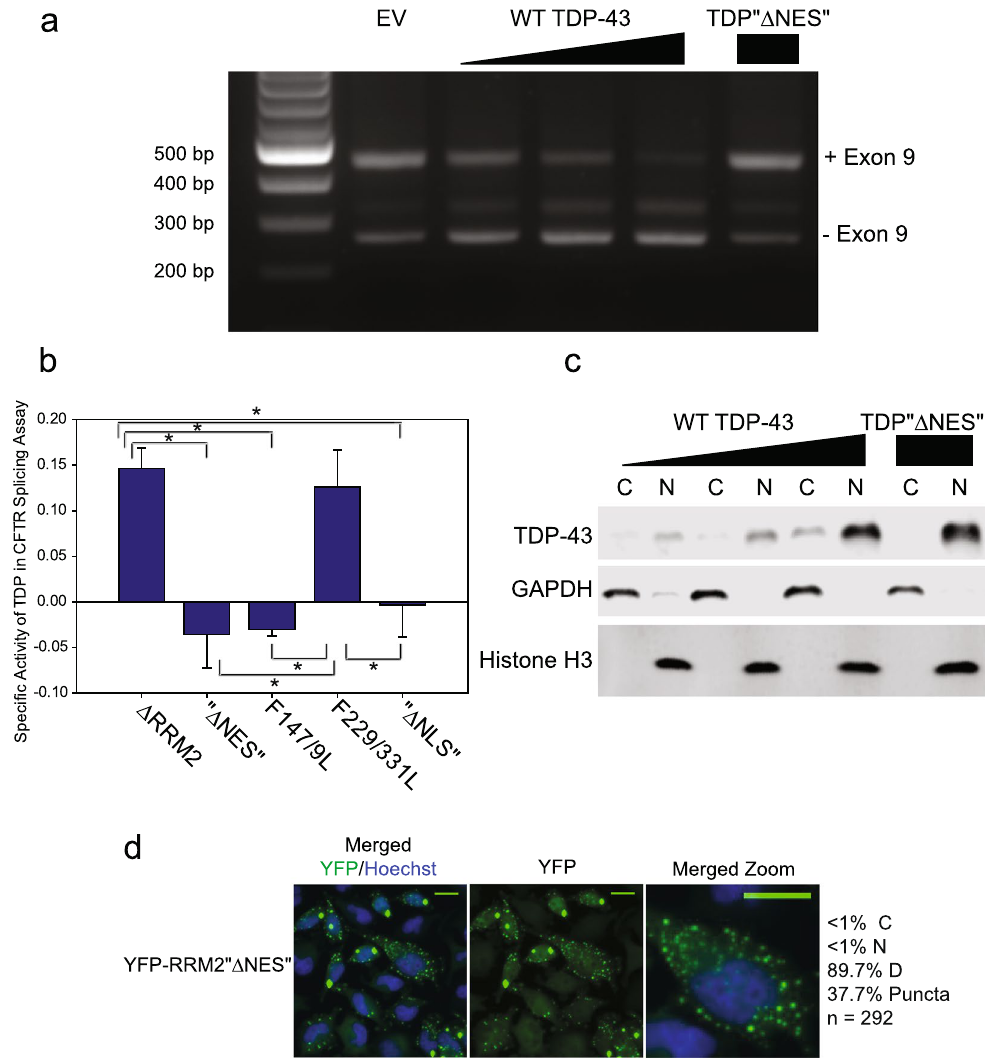
Figure 4. “ ∆ NES” Mutations profoundly disrupt TDP-43 function. ( a ) CFTR exon splicing Assay. HeLa were cells co-transfected with the CFTR minigene and either empty vector (EV) or TDP-43. cDNA was PCR amplified and run on an agarose gel. Image is representative of three independent experiments. Uncropped image shown in Supplementary Fig. 4a. ( b ) qPCR analysis of HeLa cells co-transfected with the CFTR minigene and TDP-43. The “ + 9” and “ − 9” isoforms were detected with sequence specific primers. The specific activity: (( + 9)/( − 9))/(TDP-43) was calculated for each TDP-43 variant and normalized to WT (set to 1). The mean and standard deviation from three independent experiments are plotted (WT not shown). Statistical analysis using one-way ANOVA was performed, WT varied significantly from all mutants, with p < 0.001. * indicates additional significant difference between groups, p < 0.001. ( c ) Western blot of cytosolic “C”, and nuclear, “N”, fractions of lysate from cells in 3 A. GAPDH (Glyceraldehyde 3 phosphate dehydrogenase) acts as a marker and loading control for the cytosolic fraction, while Histone H3 acts as a marker and loading control for the nuclear fraction. Image is representative of three independent experiments. Uncropped images shown in Supplementary Fig. 4b. ( d ) Direct fluorescence of HeLa cells expressing the indicated fusion protein and treated with nuclear stain Hoechst. Merged image (Hoechst and YFP), YFP, and a close-up of Merged are shown. Scale bars are 10 um. Cells from 3 independent experiments were categorized as nuclear “N”, “C” cytosolic, or “D” distributed. Apoptotic and mitotic cells were not categorized but were included in total cell count. Percentage of cells containing puncta is also indicated. n = number cells